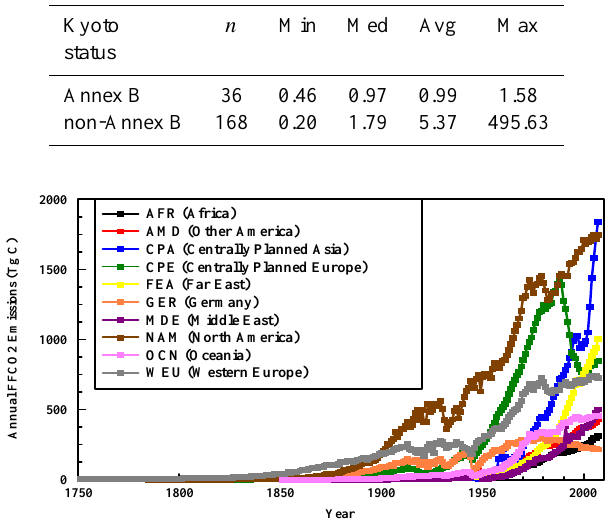
Fig. 4. Regional FFCO2 emissions for the years 1751 to 2007. This figure was created from the sum of national consumption values (see section 1) for 15,830 country-year pairs. See Boden et al. (2010) for which countries are included in each region. Data from Boden et al. (2010).